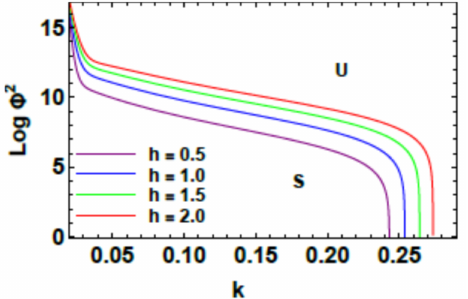
Figure 3. Plots of the stability bound for h for different values the parameter k versus Log Φ 2 .